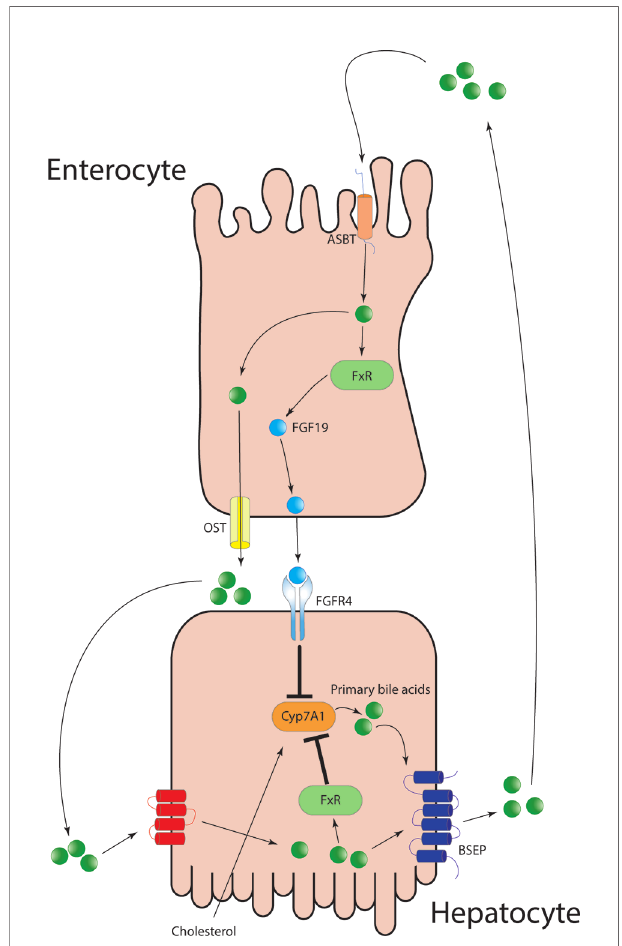
FIGURE 1 | Primary bile acids after being secreted from the hepatocytes into the bile, are reabsorbed in the terminal ileum via the apical-sodium dependent bile acid transporter. The increased intracellular concentration of BAs is sensed via FXR and lead to the production of fi broblast growth factor 19 and to its secretion into the portal circulation. FGF19 binds FGF4 on hepatocytes surface and lead to the downregulation of Cyp7A1 and in turn inhibiting de- novo primary bile salt